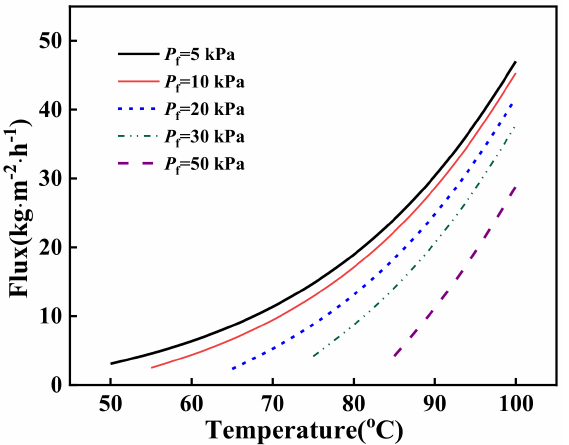
Figure 2. Effects of pressure and temperature on water permeate